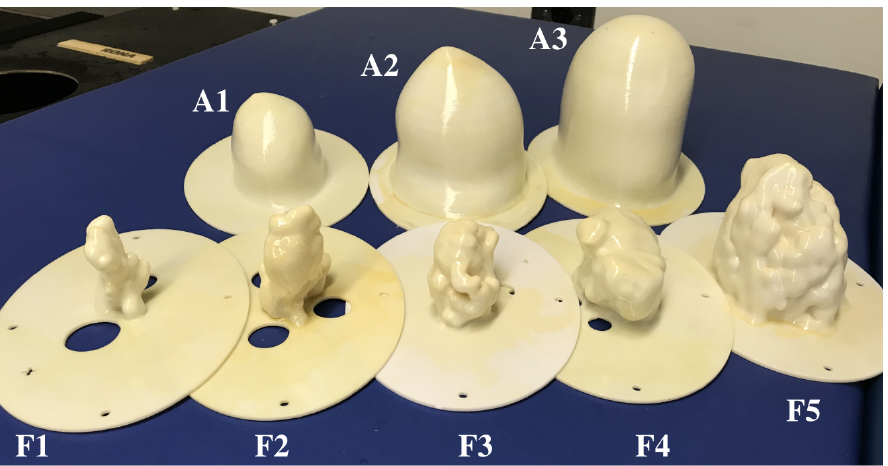
Figure 2. The array of 3D-printed MRI-derived breast phantoms. Adipose shells labeled A1 through A3, fibroglandular shells labeled F1 through F5.